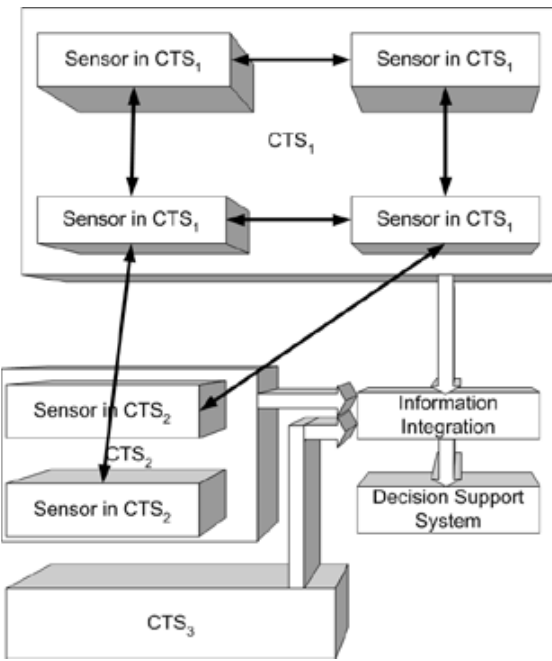
Fig. 2. Knowledge Sharing among different CTS